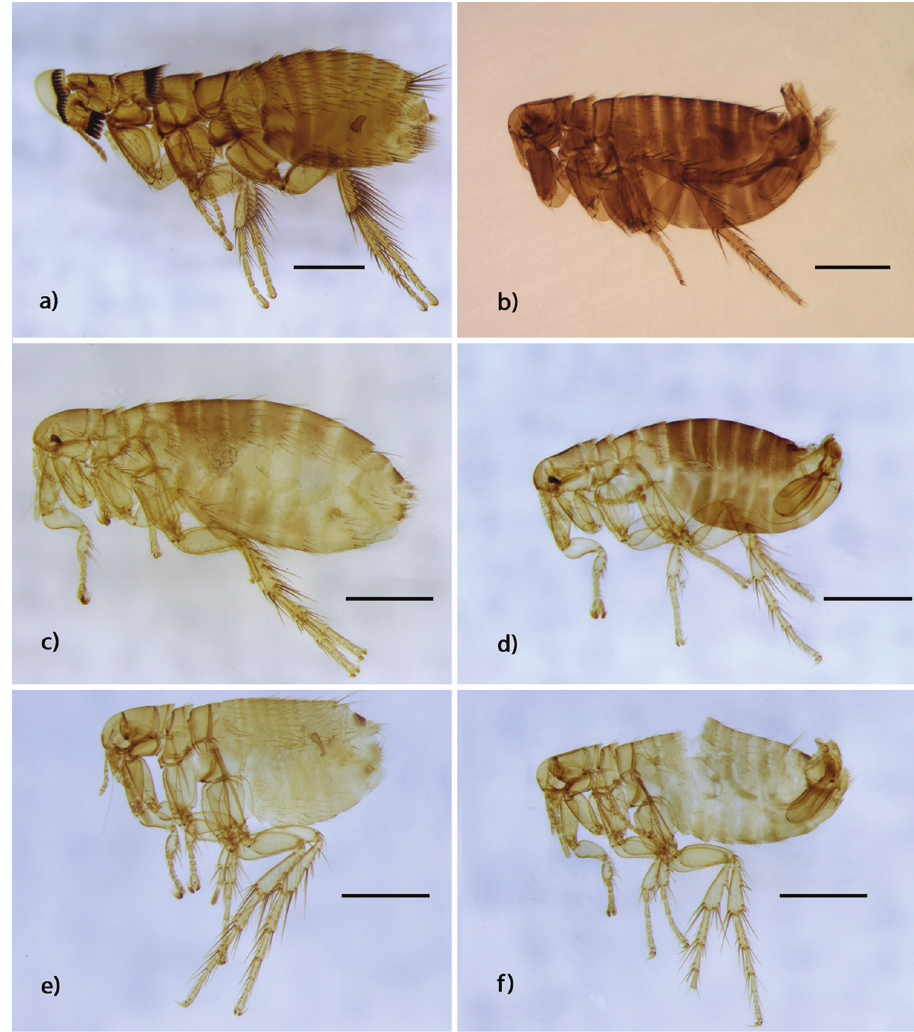
Figure 2. Species of fleas representing the first record for La Rioja Province, Argentina. a Craneopsylla minerva , ♀ CMLA (608) (Stephanocircidae b Polygenis ( Polygenis ) acodontis , ♂ CMLA (674) (Rhopalop- syllidae) c Delostichus talis , ♀ CMLA (616) (Rhopalopsyllidae) d Delostichus talis , ♂ CMLA (619) (Rho- palopsyllidae) e Tiamastus palpalis , ♀ CMLA (631) (Rhopalopsyllidae) f Tiamastus palpalis , ♂ CMLA (629) (Rhopalopsyllidae). Scale=500